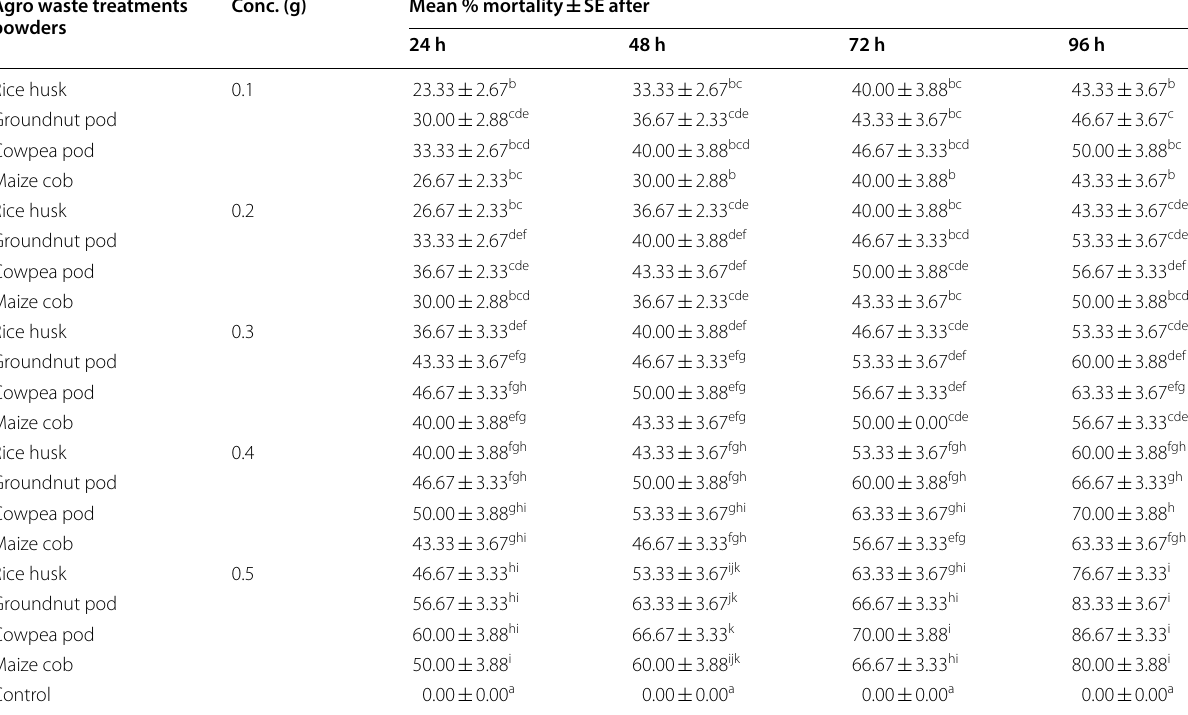
Mean followed by the same letters within the same column are not significantly different ( p > 0.05)